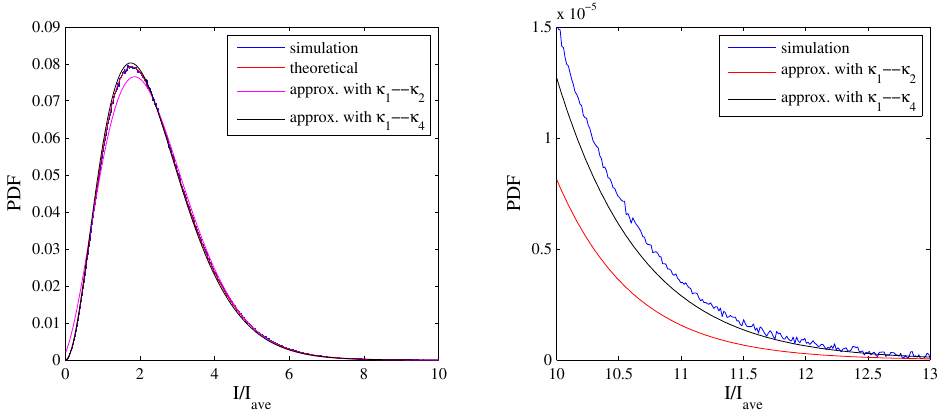
Figure 3. Interference power distributions for J = 3 independent interferers. The average interference powers are I ave,1 = I ave,2 = I ave,3 = I ave /3. The instantaneous interference powers at the time of measurement are I 0,1 = 3/2 I 0,2 = 3 I 0,3 = I ave /2, so that the total measured interference power